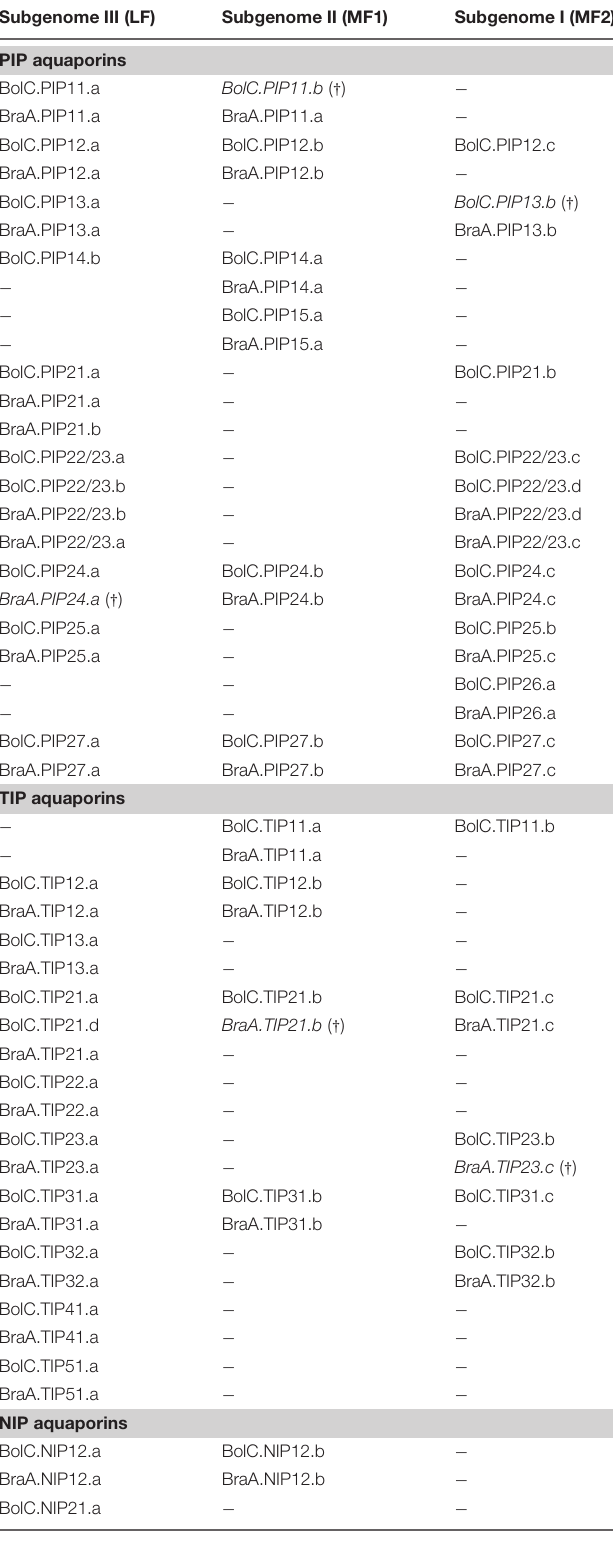
TABLE 2 | Distribution of aquaporin genes in the three subgenomes of Brassica oleracea and Brassica rapa . Subgenome III (LF) Subgenome II